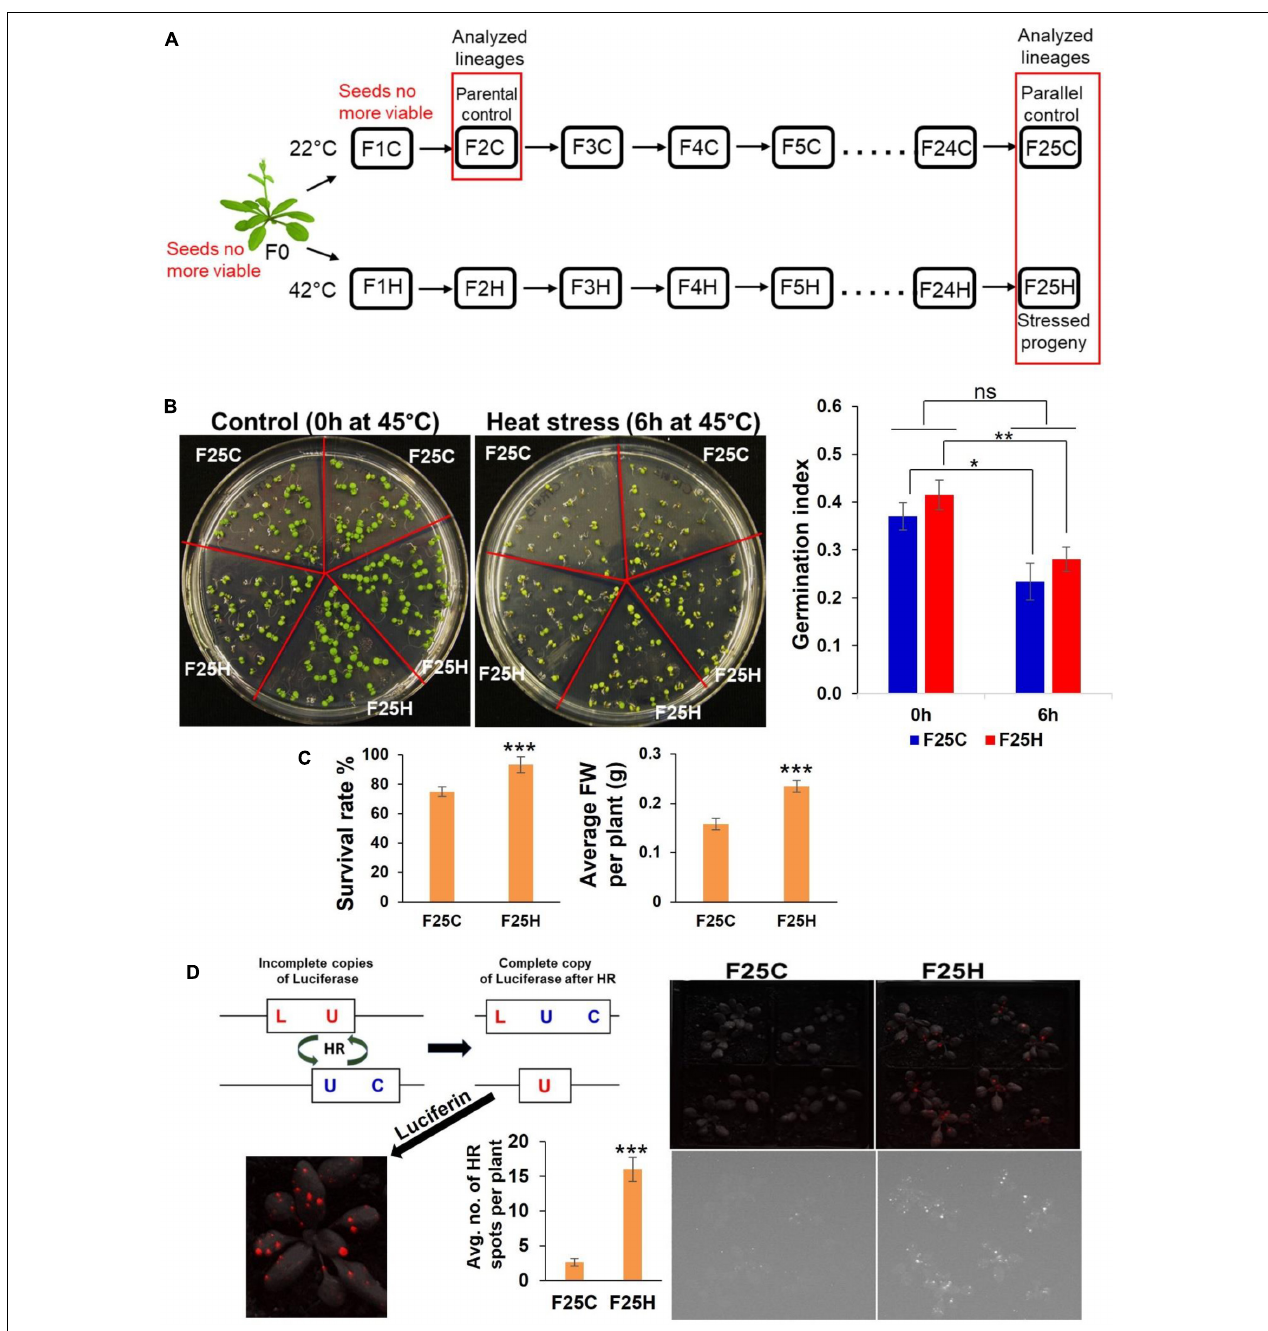
FIGURE 1 | The heat-stressed progeny exhibited an increase in heat stress resilience and higher frequency of recombination events. (A) Schematic diagram for propagations of 25 generations of heat stressed and parallel control lineages. Single Arabidopsis thaliana plant (Col-0, 15d8 line ) was used for seed origin. Plants were grown for 25 generations either exposed to heat stress (42 ◦ C) or in a control ambient environment (22 ◦ C). The ‘H’ group included the heat-stressed progenies, while the ‘C’ group included plants grown under control conditions acting as a parallel control. Seeds of second-generation F2C were used as parental control because seeds of F0 and F1C were no longer viable. Lineages used in this study are shown in the red box. (B) Trends in the germination of the F25H progeny under heat stress. Representative photographs of germination under control (0 h) and heat-stress (6 h) conditions (the left panel). Seeds were either from the parallel control (F25C) or the heat-stressed progeny (F25H). Each plate represents one set, and in total, five sets were used for each treatment. The right panel: The germination index graph. 0 h: non-stress control (0 h at 45 ◦ C); 6 h: heat-stress (6 h at 45 ◦ C). Heat-stress was applied at 45 ◦ C for 6 h, just 4-days after stratification at 4 ◦ C. The germination index was measured on the 6th day. The data were analyzed by two-way ANOVA with the Tukey’s multiple comparisons test using GraphPad Prism version 8.4.2 for Windows. The data are shown as an average mean ± SD. Mean values that were significantly different from each other are indicated by